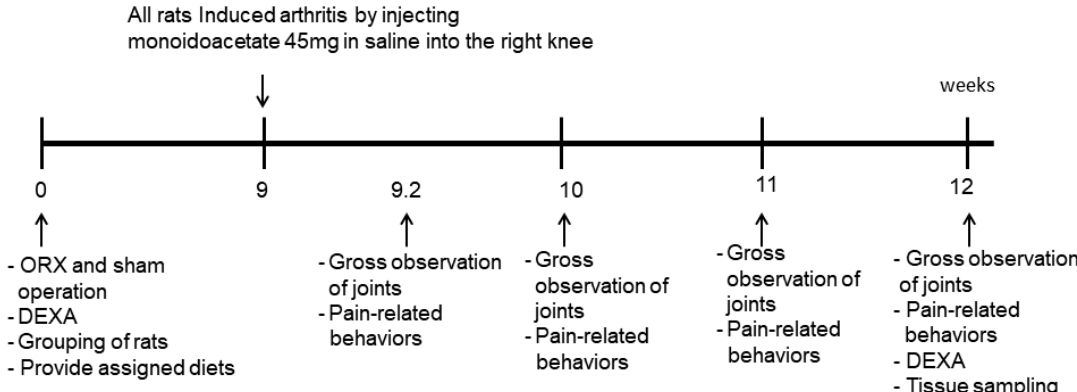
Figure 1. Timeline of the experiments. ORX-CON, ORX male rats with induced osteoarthritis and 43% fat diet with 0.5% dextrin; ORX-CFW, ORX male rats with induced osteoarthritis and 43% fat diet plus 0.5% CFW; ORX-MBW: ORX male rats with induced osteoarthritis and 43% fat diet plus 0.5% MBW; Non-ORX-CON, Sham-operation of ORX male rats with induced osteoarthritis and 43% fat diet with 0.5% dextrin. CFW, Water extract of Cornus officinalis Siebold and Zucc fruits; MWB, water extract of Morus alba L root bark; DEXA, dual-energy X-ray absorptiometry.